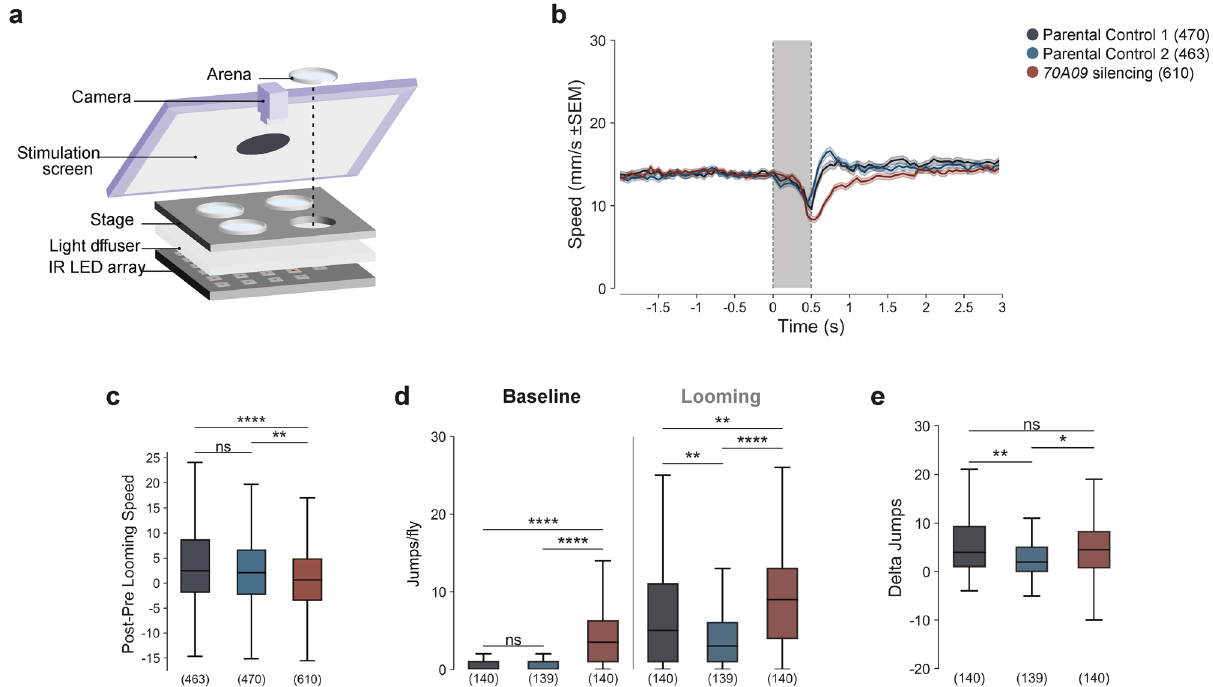
Figure 3. Silenced 70A09 females show less vigorous escape responses when exposed to a threat. ( a ) Schematic of the experimental setup used to characterise escape behaviours in response to looming stimuli 40 . Genotypes: + /w-, UAS > STOP > kir2.1; otd-nls:FLPo/ + ; + (Parental Control 1), + /w-; + ; 70A09 GAL4/ + (Parental Control 2) and + /w, UAS > STOP > kir2.1; otd-nls:FLPo/ + ; 70A09-GAL4/ + (70A09 silencing). In b and c only looming events where flies were walking before and after the stimulus were